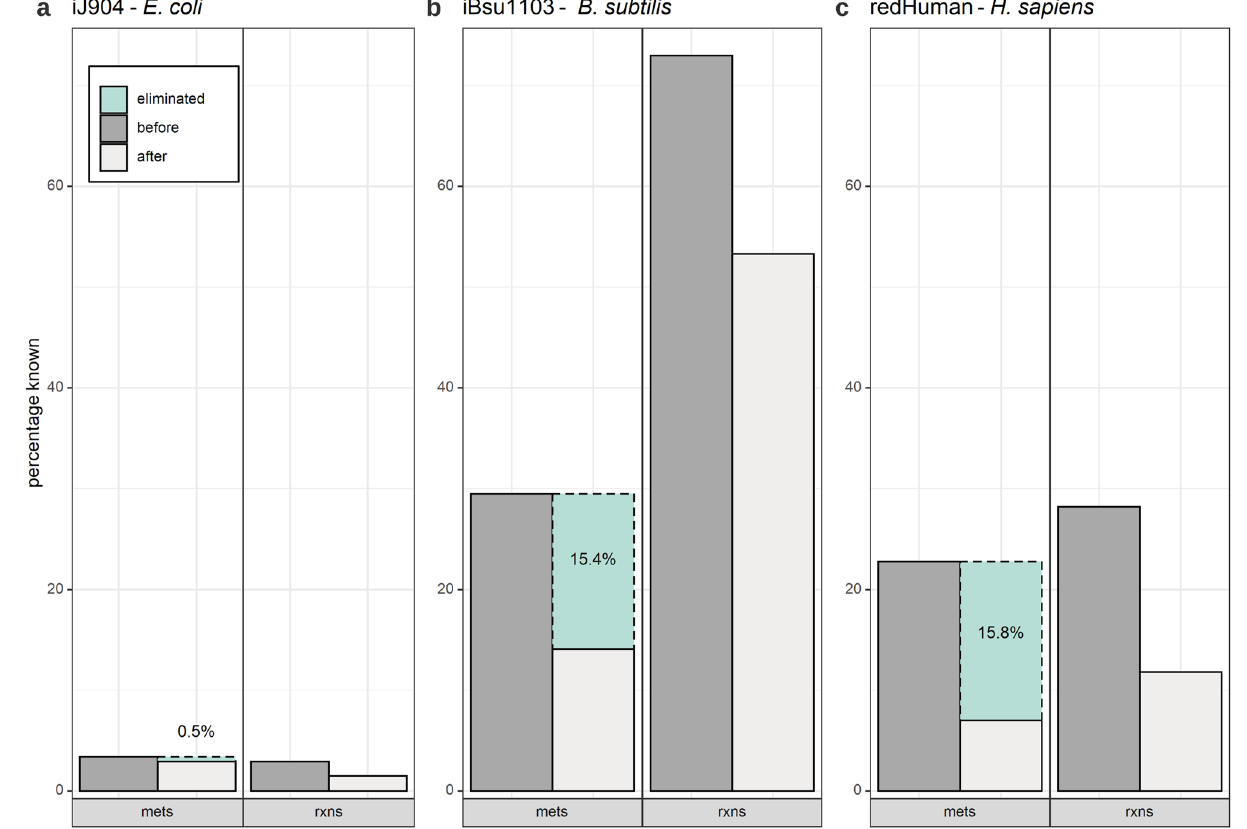
Figure 2. Application of lumping on genome-scale metabolic models. The percentage of reactions with unknown (cid:31) G 0 is in three GEMs, ( a ) iJR904, ( b ) iBsu1103, and ( c ) redHuman, reduced after lumping due to elimination of metabolites with unknown ∆ f G 0 . Shown is the percentage of unknown (cid:31) G -values in relation to the total number of present metabolites (mets) and reactions, respectively, (rxns) before and after the lumping procedure was applied. The number of eliminated metabolites with unknown ∆ f G 0 is with respect to the total number of metabolites. The investigated genome-scale models have low, high and medium number of unknown 0 , respectively, and pertain to organisms of increasing (cid:31) G 0 and ∆ f G